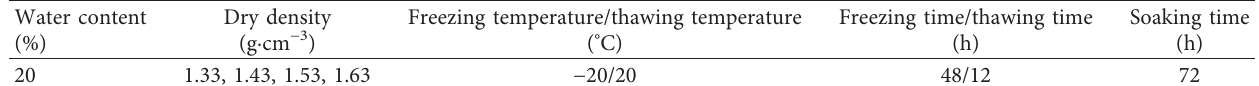
Table 4: Shear strength test conditions of dispersive soil.